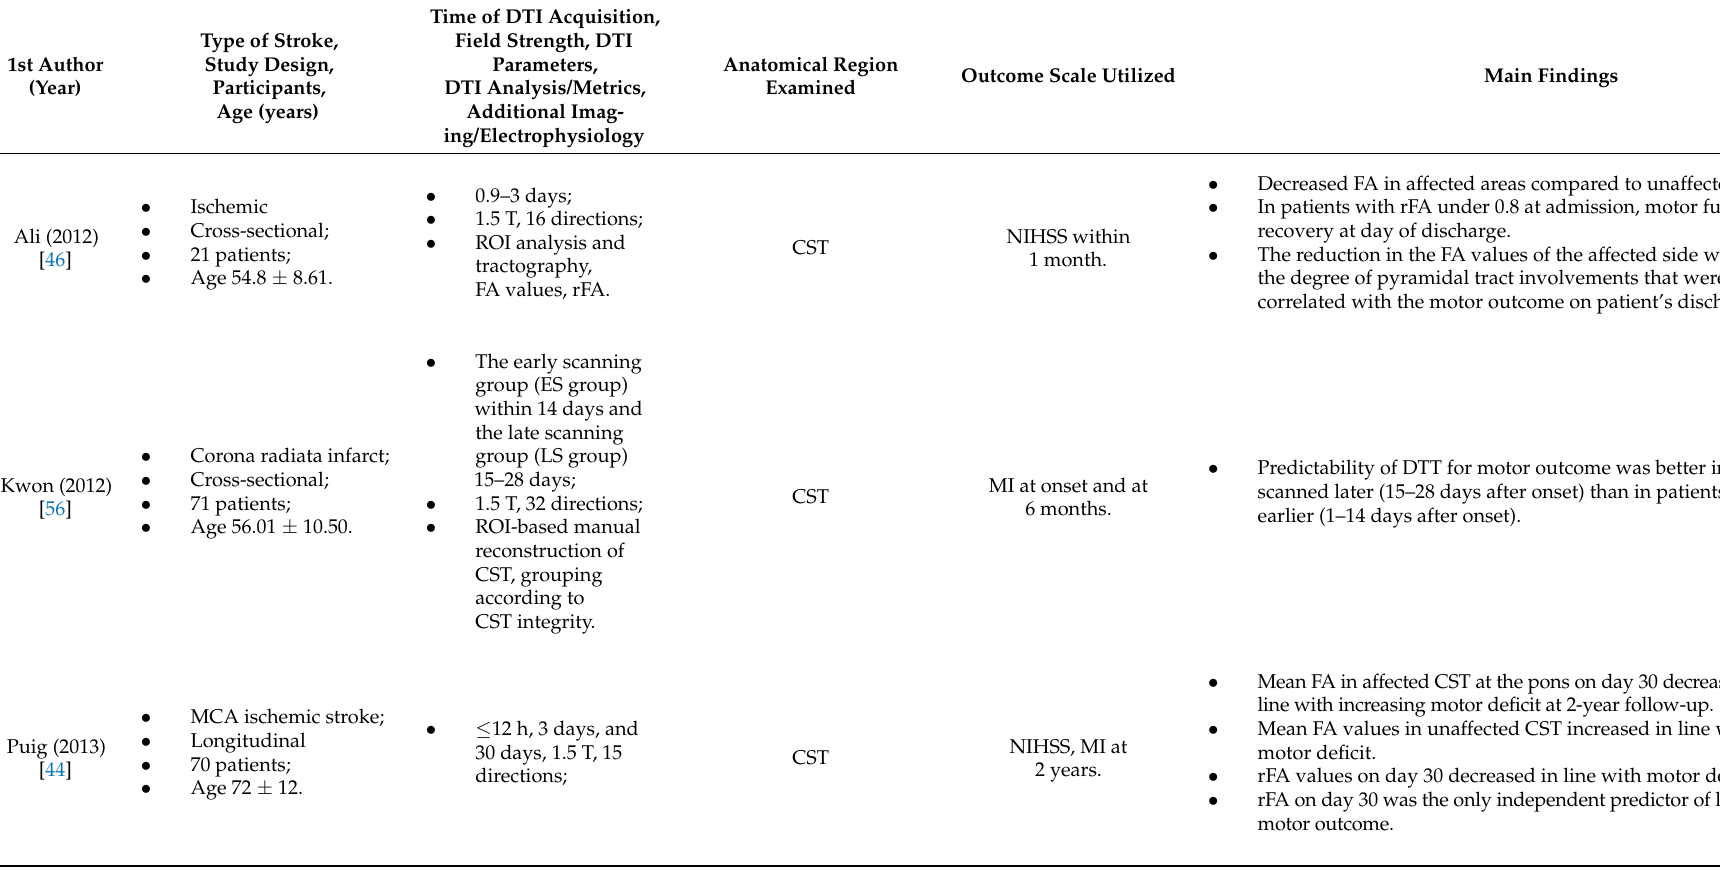
Table 1. Basic characteristics and main findings of studies including patients with ischemic